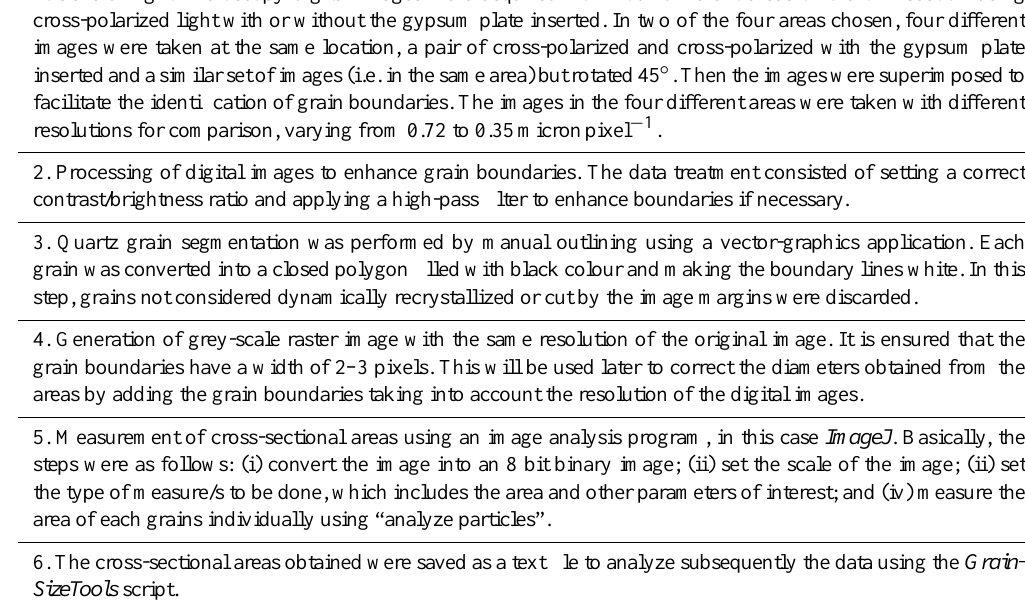
Table 1. Steps for obtaining the cross-sectional areas of the grains using the ImageJ application. 1. Several light microscopy digital images were acquired from four different areas of the thin section using cross-polarized light with or without the gypsum plate inserted. In two of the four areas chosen, four different images were taken at the same location, a pair of cross-polarized and cross-polarized with the gypsum plate inserted and a similar set of images (i.e. in the same area) but rotated 45 ◦ . Then the images were superimposed to facilitate the identification of grain boundaries. The images in the four different areas were taken with different resolutions for comparison, varying from 0.72 to 0.35micronpixel − 1